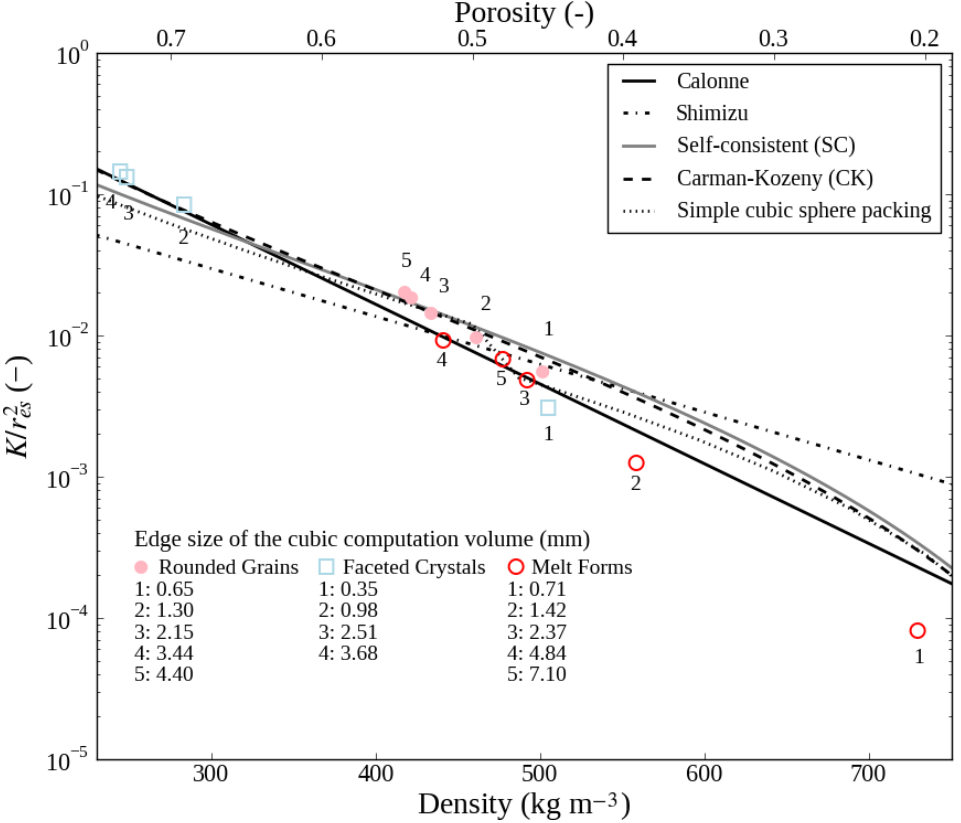
Fig. 6. Dimensionless permeability versus snow density for three snow samples. Symbols and colors correspond to the ICSSG (Fierz et al., 2009). For a given sample, each symbol represents a particular volume from which K , SSA and ρ s were computed. The largest volume corresponds to the total volume of the sample. Analytical models and fits are also plotted.